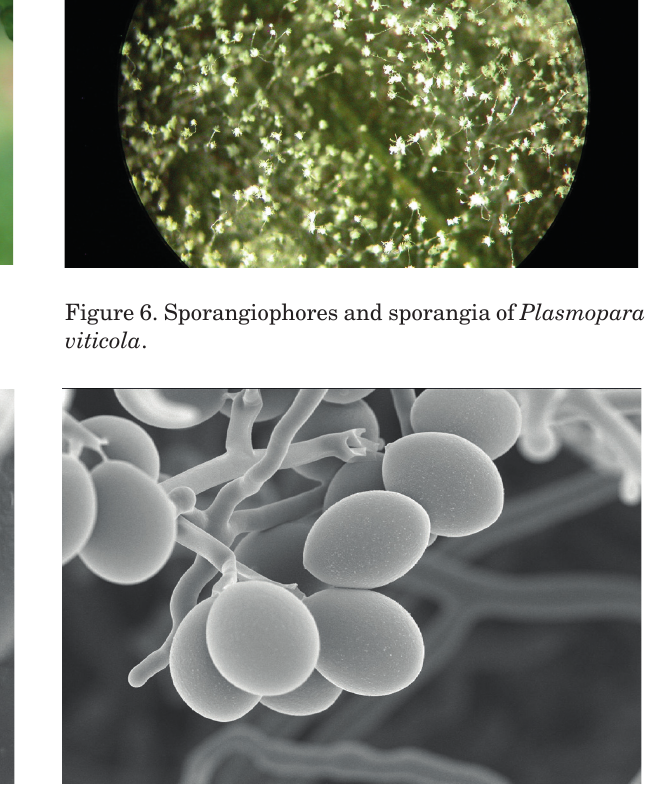
Figure 8. Sporangia on